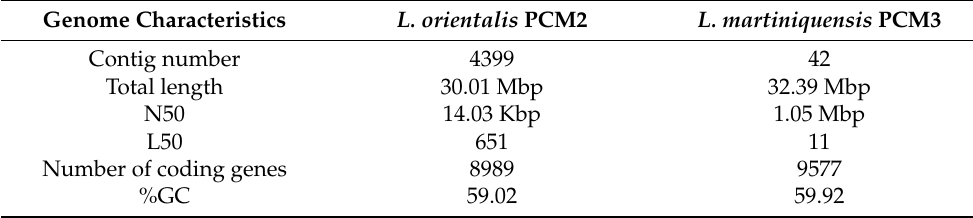
Table 1. Basic characteristics of draft genomes of L. orientalis isolate PCM2 and L. martiniquensis isolate PCM3 from the southern part of